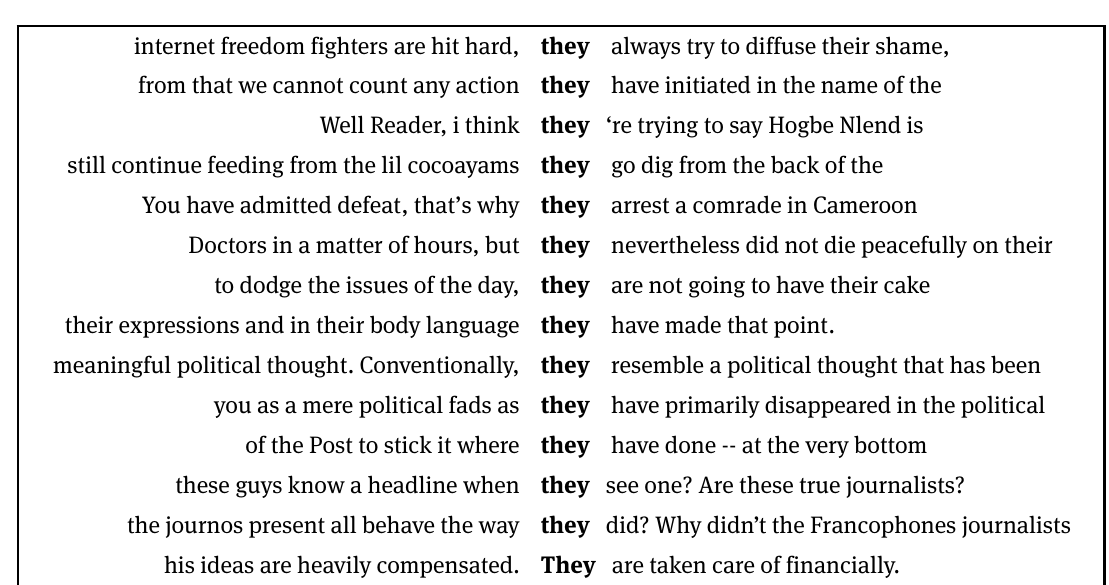
Figure 7. Sample concordance list for